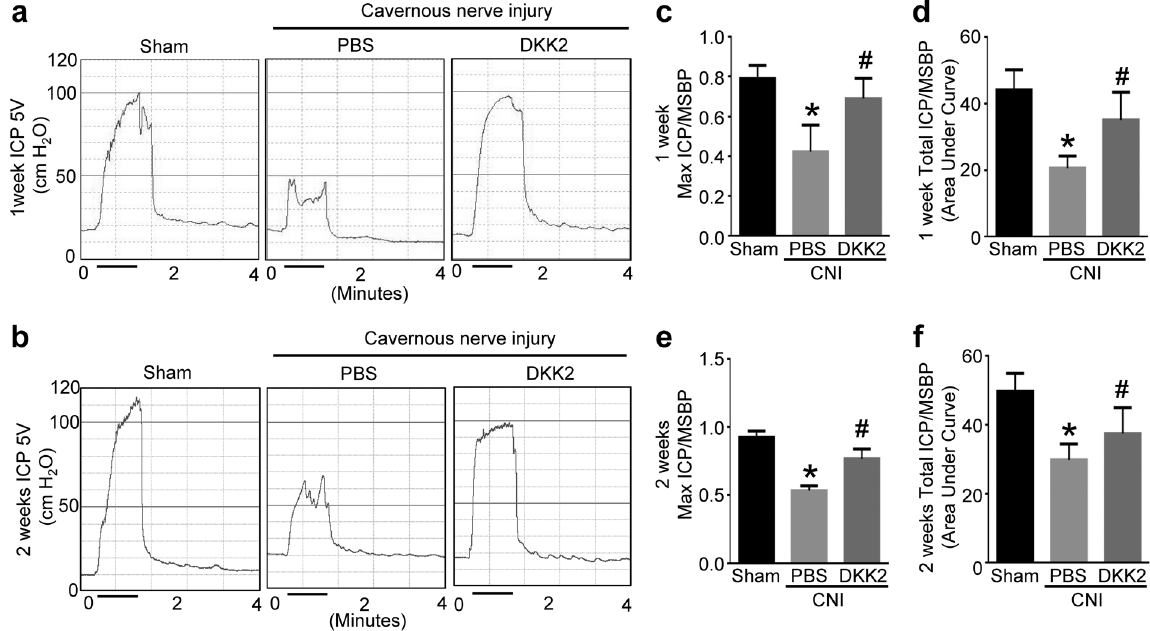
Figure 1. DKK2 restores intracavernous pressure (ICP) elicited by electrical stimulation of the cavernous nerve. ( a , b ) Representative ICP responses for the sham operation group or CNI mice stimulated at 1 or 2 weeks after intracavernous injections of PBS (20 μ l) or DKK2 protein (days -3 and 0; 6 µ g/20 µ l). The stimulus interval is indicated by a solid bar. (c – f) Ratios of mean maximal ICP and total ICP (area under the curve) to mean systolic blood pressure (MSBP) were calculated for each group. Each bar depicts the mean ( ± SE) values from n = 6 animals per group. * P < 0.001 vs. sham operation group, # P < 0.05 vs. PBS-treated CNI group. CNI = cavernous nerve injury; DKK2 =